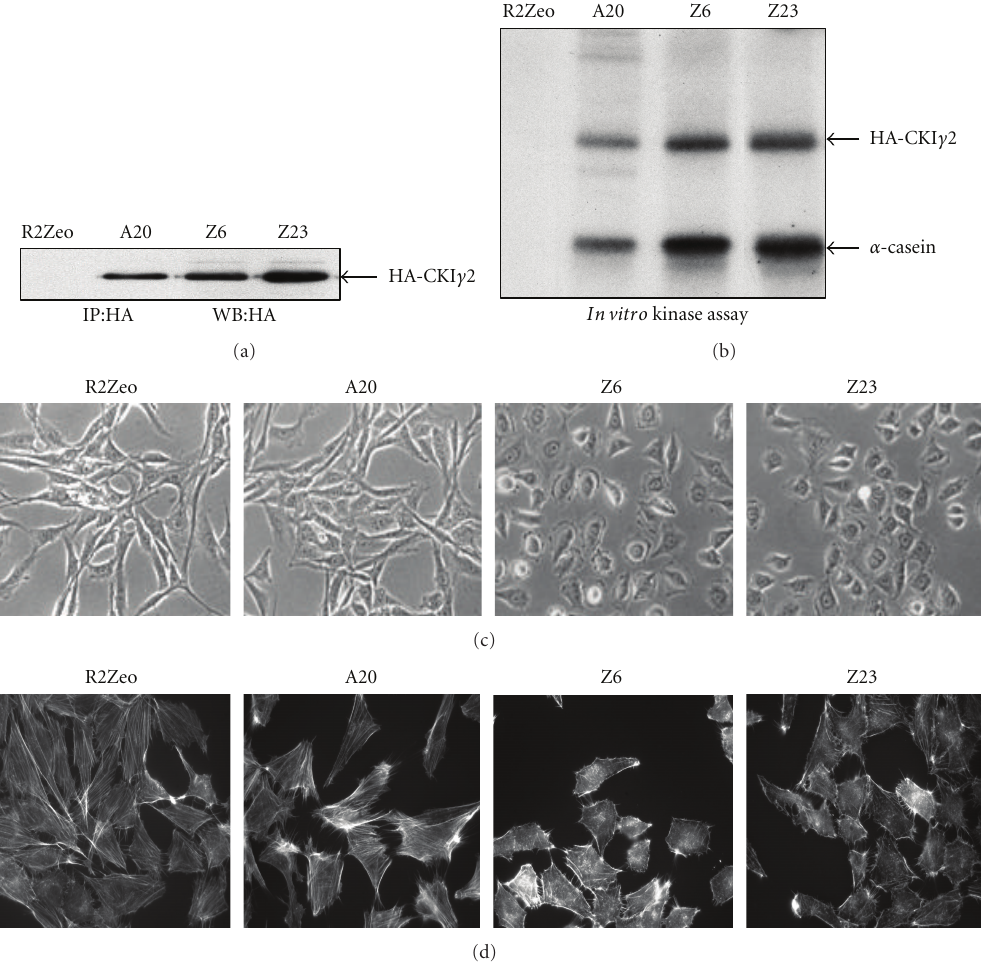
Figure 1: CKI γ 2 overexpression in fibroblasts alters cell morphology and actin stress fibers formation. (a) Isolated clones of fibroblasts stably transfected with a plasmid encoding HA-tagged-CKI γ 2 (A20, Z6, and Z23) or pool of stable cells transfected with an empty plasmid (R2Zeo) were analyzed for HA-CKI γ 2 expression by Western Blot (WB) on HA immunoprecipitates (IP). (b) CKI γ 2 activity determined on HA immunoprecipitates in in vitro kinase assays using phosphorylation of exogenous α -casein. (c) Indicated serum growing cells were analyzed for cell morphology by phase contrast microscopy (40X) and (d) actin organization using rhodamine-conjugated phalloidin staining (63X). R2Zeo: control; A20, Z6, and Z23: clones overexpressing increasing levels of CKI γ